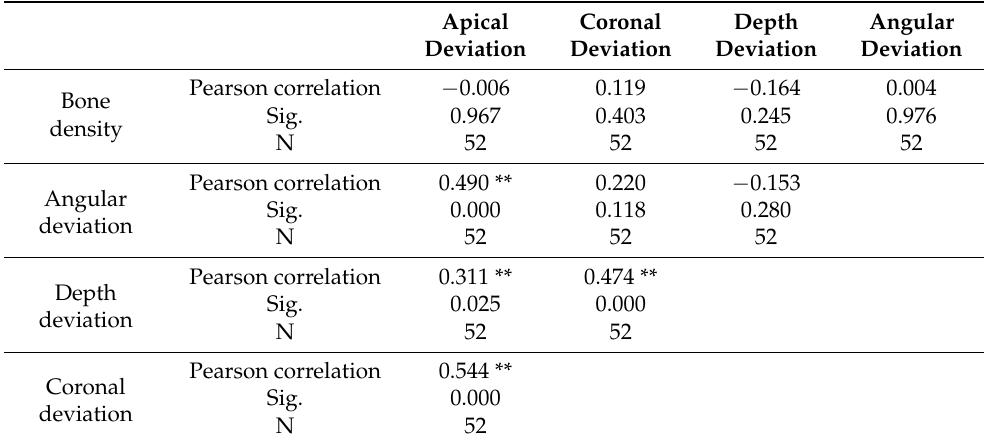
Table 5. Correlation between the bone density and the different deviation parameters. ( p value) (N = 52).